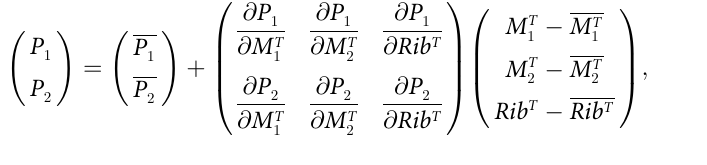
and P of single cells, r( P , P ). Calculation of r( P , P ) is 1 2 1 2 1 2